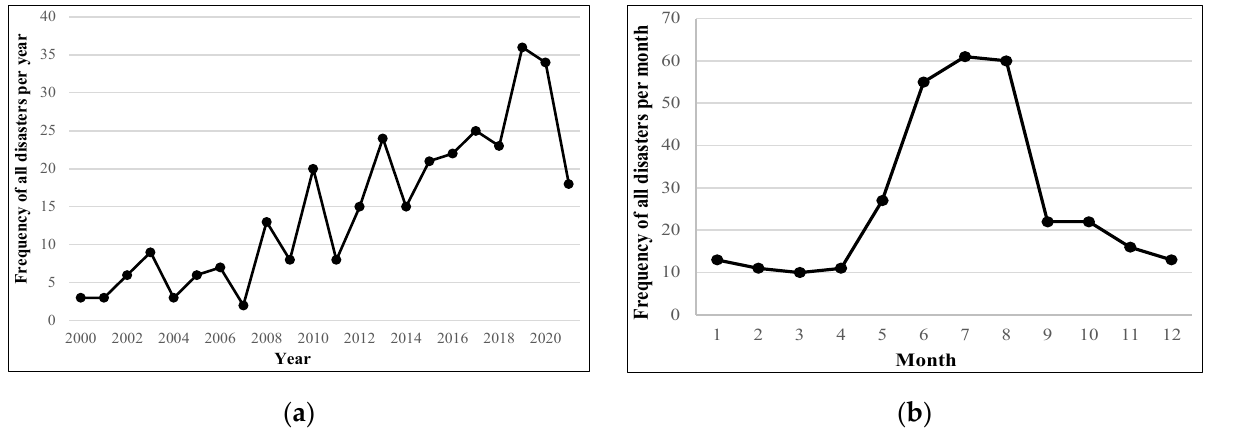
Figure 6. Frequency Statistics of Geological Hazards along the Railway: ( a ) Inter-Annual Frequency Statistics of Geological Hazards along the Railway; ( b ) Statistics on the Monthly Frequency of Geological Hazards along the Railway.